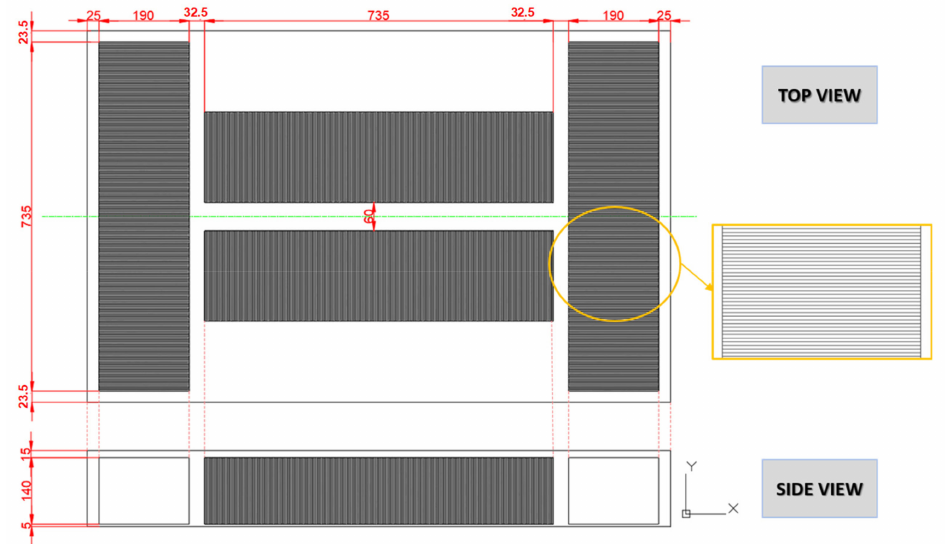
Figure 11. Pack schematic of configuration 9 with BLB2 pouch cells in the floor integration installation of reference